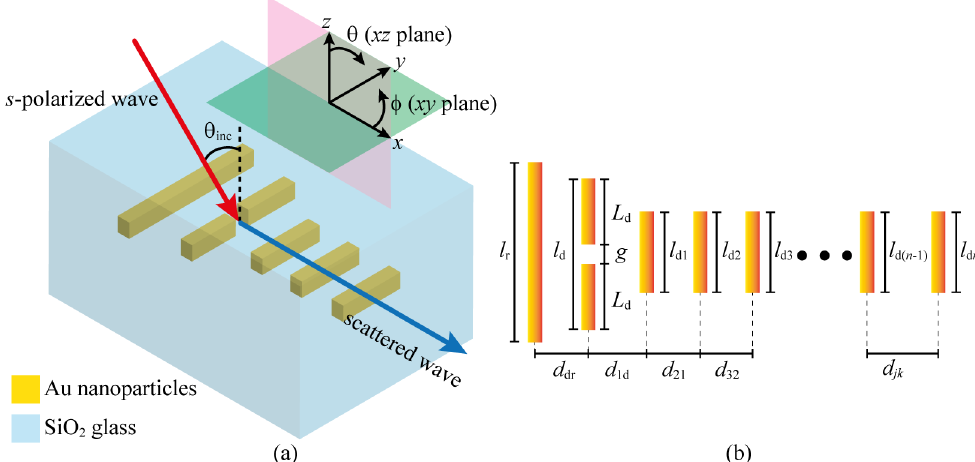
Figure 1. ( a ) Pictorial representation of a generic plasmonic Yagi–Uda nanoantenna (made of Au) embedded in silica. The nanoantenna elements and their geometries are illustrated in ( b